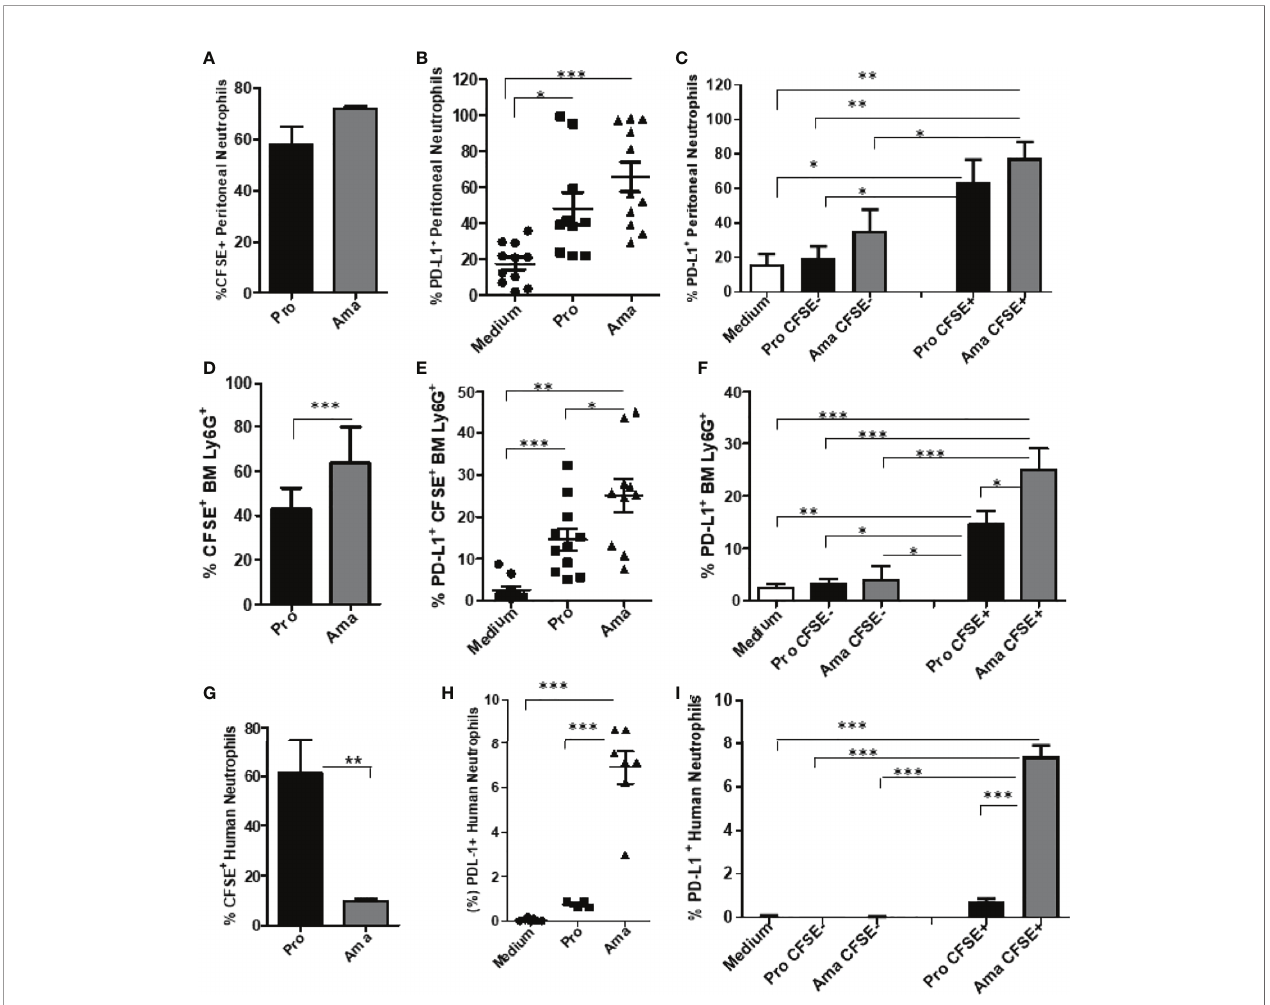
FIGURE 1 | Increased expression of PD-L1 in murine and human neutrophils exposed to challenge with L. amazonensis . BALB/c neutrophils (5x10 5 ) recruited to the peritoneum with casein, or puri fi ed from bone marrow, and human neutrophils (5x10 5 ) from healthy donors were incubated with CFSE-stained promastigotes (Pro) and amastigotes (Ama) of L. amazonensis (murine 1:10; human 1:5), for 4 h. Control was performed with neutrophils on medium. Cells were then analyzed by fl ow cytometry using Ly6G + -Percp (neutrophils), CFSE + ( L. amazonensis ) and PD-L1 + -APC. (A) Percentage of peritoneal neutrophils infected with CFSE-labeled parasites. (B) Percentage of PD-L1 + peritoneal neutrophils upon interaction with parasites. (C) Percentage of PD-L1 expression on CFSE - (bystander) and CFSE + casein- recruited neutrophils. (D) Percentage of bone marrow (BM) neutrophils infected with CFSE-labeled parasites. (E) Percentage of PD-L1 + bone marrow neutrophils upon interaction with parasites. (F) Percentage of PD-L1 expression on CFSE - and CFSE + bone marrow neutrophils. (G) Percentage of human neutrophils infected with CFSE-labeled parasites. (H) Percentage of PD-L1 + human neutrophils upon interaction with parasites. (I) Percentage of PD-L1 expression on CFSE - and CFSE + human neutrophils. Data are mean ± SEM (N=10-11) and human donors (N=7). Each point represents a donor. *p < 0.01, **p < 0.001, ***p <